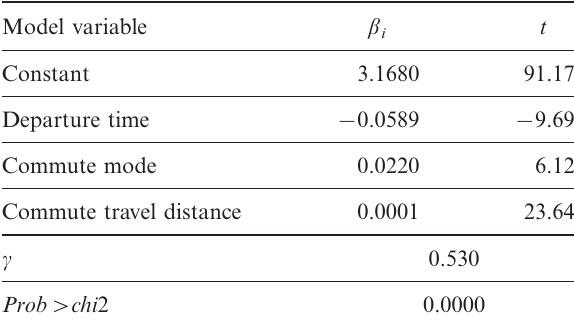
Table 7. Estimation results of the travel duration